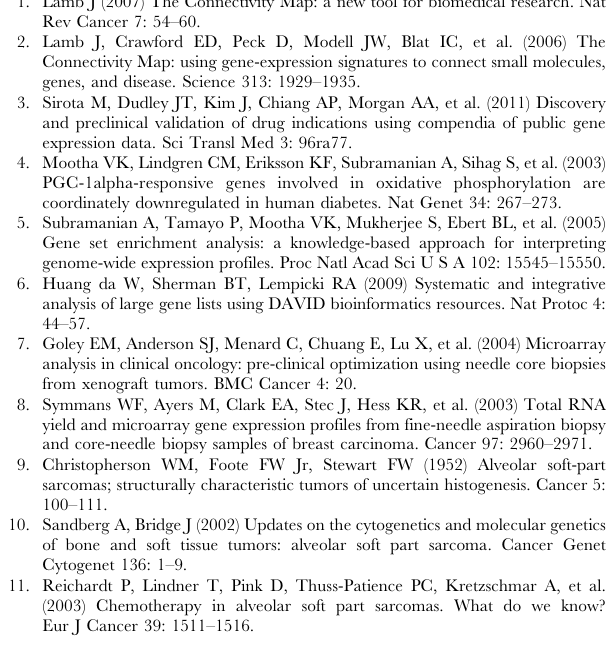
Figure S1 GSEA output for genes (y-axis) and pathways (x-axis). Black boxes indicate occurrence of 2 or more genes in a GSEA pathway. GSEA results are derived from the 542 filtered genes above the 1 st PC (See Figure 2). These genes are over expressed in ASPS-tissue relative to ASPS-1. Figure S2 GSEA output for genes (y-axis) and pathways (x-axis). Black boxes indicate occurrence of 2 or more genes in a GSEA pathway. GSEA results are derived from the 702 filtered genes below the 1st PC (See Figure 2). These genes are over expressed in ASPS-1 relative to ASPS-tissue.